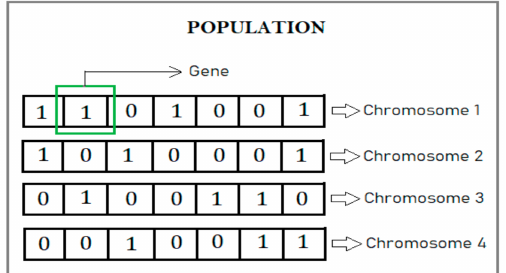
Figure 2. Representation of a population of